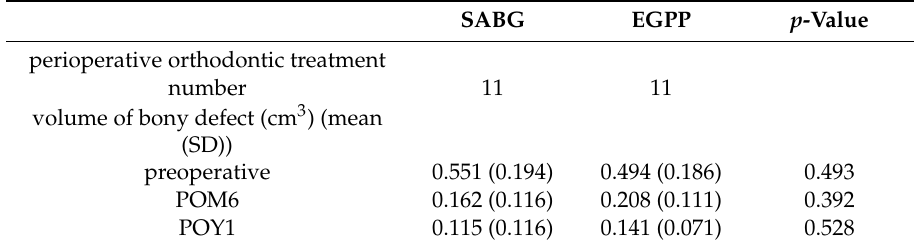
Table 2. CT volume measurement of subgroups with perioperative orthodontic treatment. SABG EGPP p